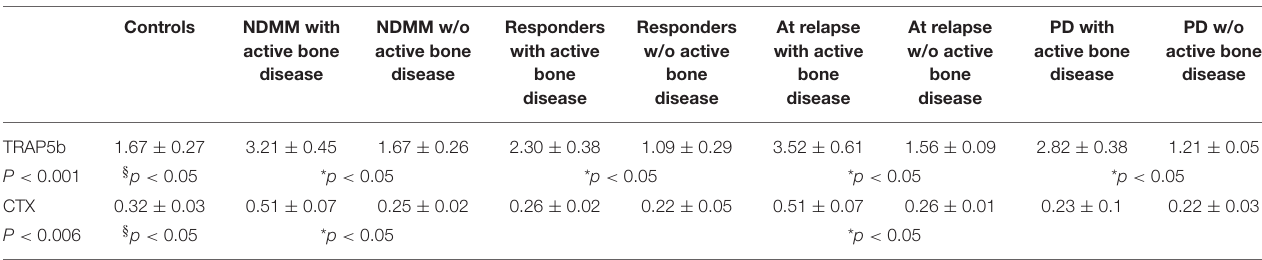
TABLE 2 | CTX and TRAP5b serum levels in controls and patients.